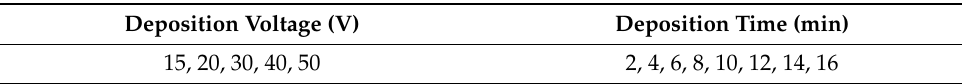
Table 1. Conditions for electrophoretic